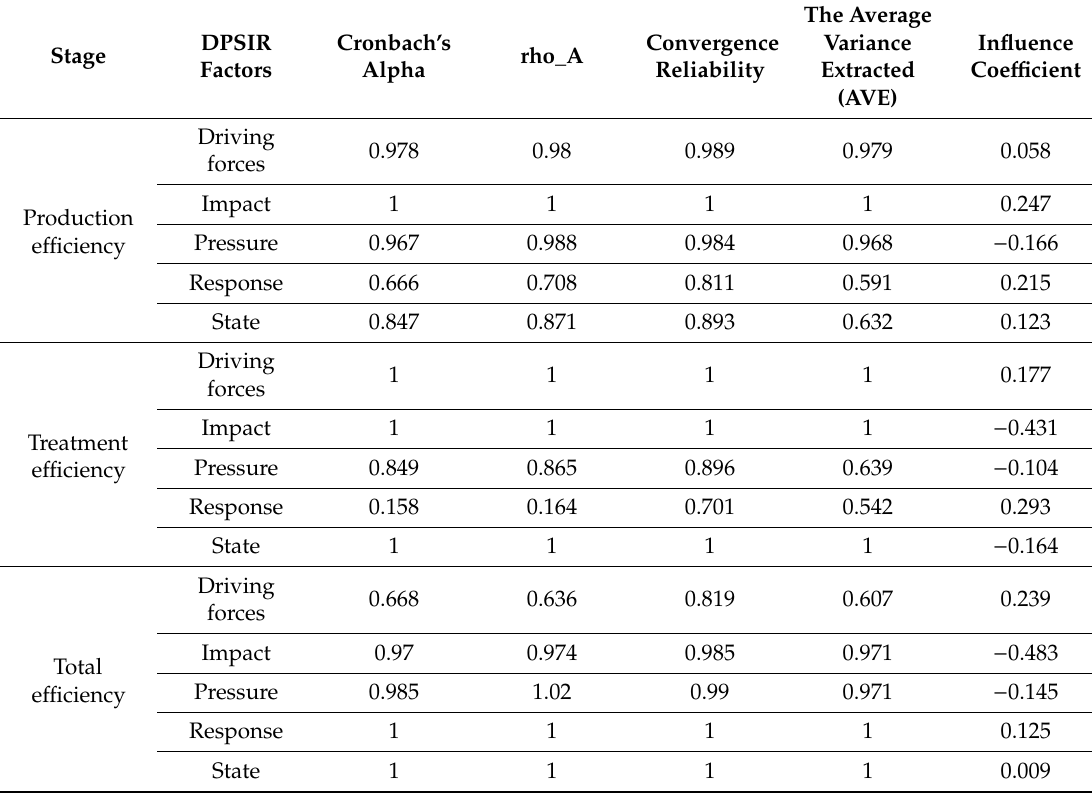
Table 6. Structural path estimates for the DPSIR